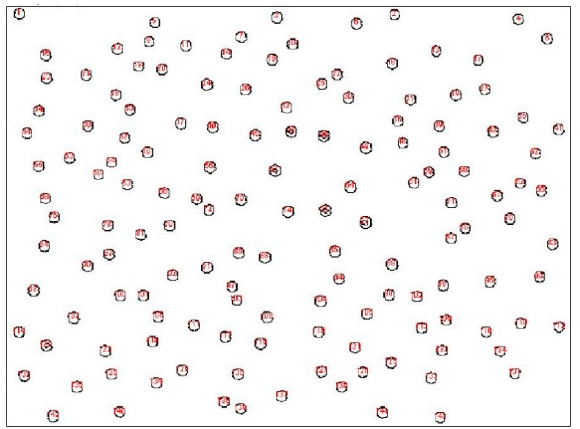
Figure 6. Binary image of condensed water droplet on silicon at 12 ∘ C for 20 s.